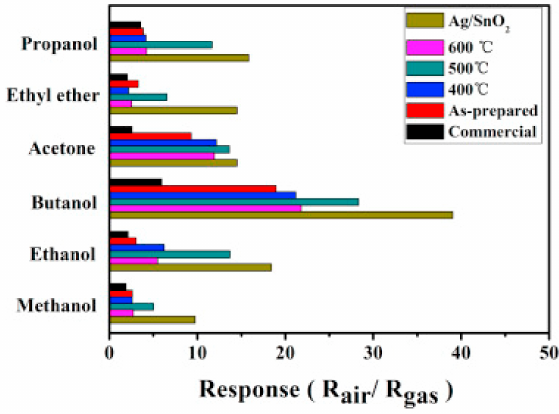
Figure 27. Sensor response of SnO 2 NPs-based sensors towards 100 ppm of different gases at the optimal working temperature. Reprinted from Ref. [220] with permission of Elsevier B.V., 2015.